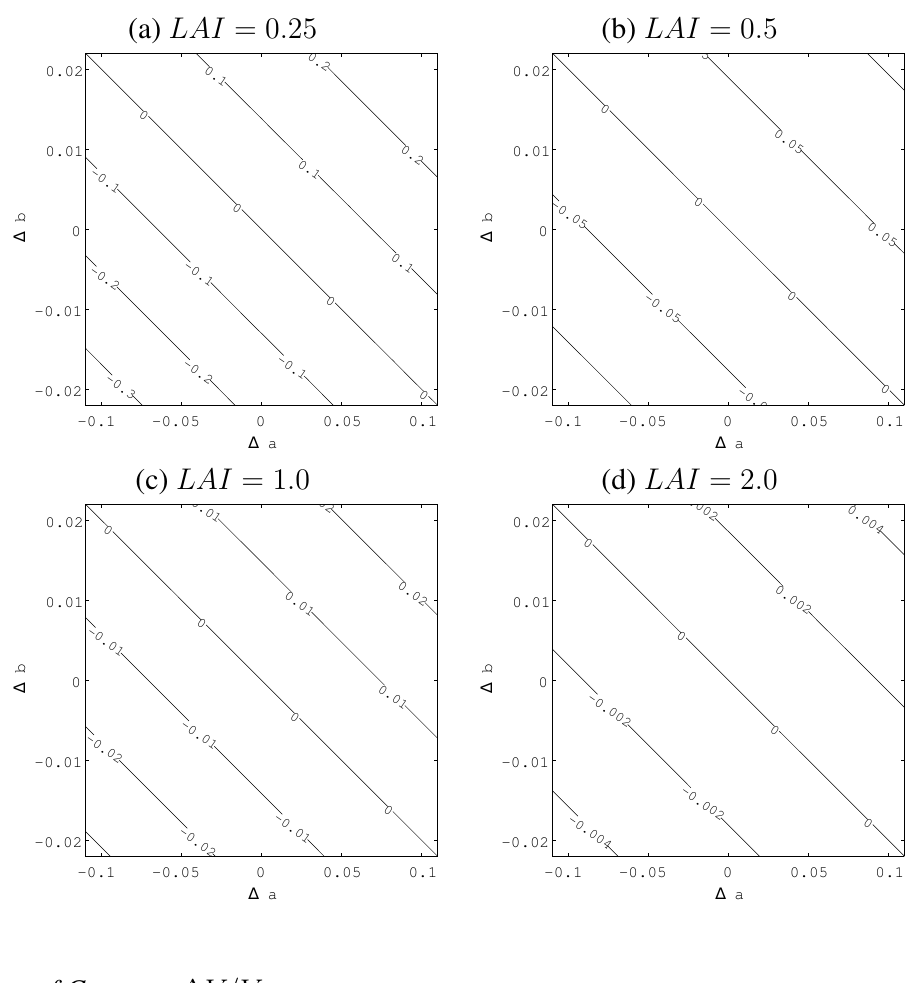
Figure 6. ∆ V=V for the four LAI